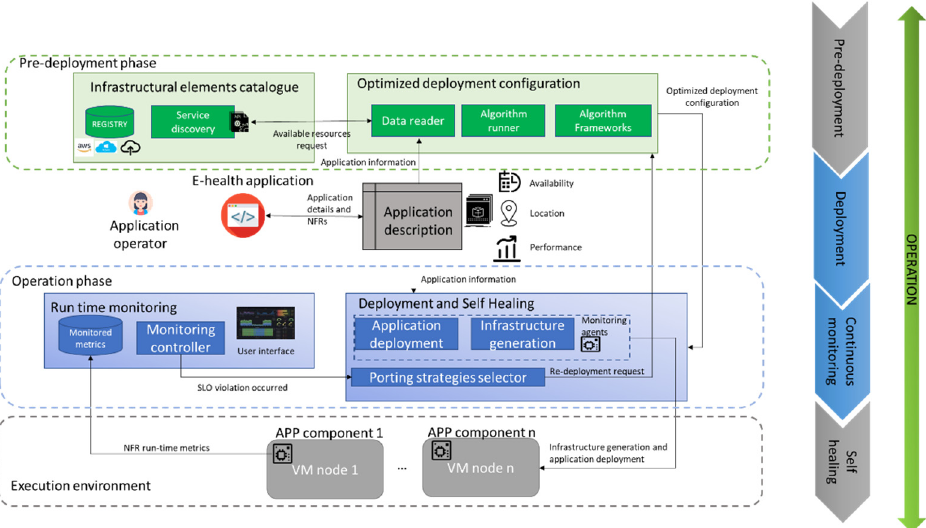
Figure 7. Architecture of the MVP of the proposed CloudOps framework validated in an e-health